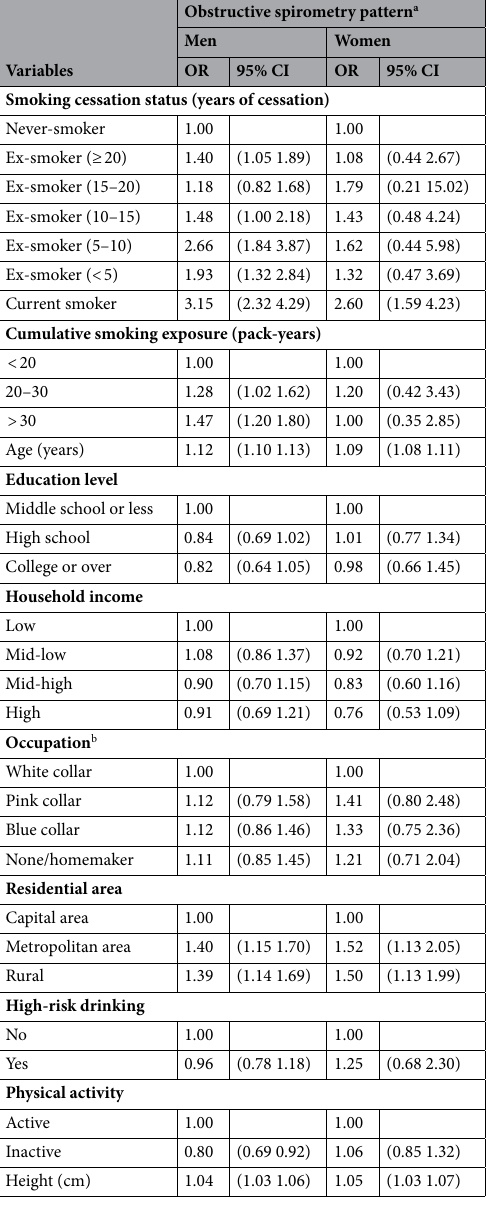
Table 2. Association between smoking cessation status and obstructive spirometry pattern. OR odds ratio, CI confidence interval. a Obstructive spirometry pattern was defined as an FEV 1 /FVC < 0.7. b Based on the International Standard Classification Occupations